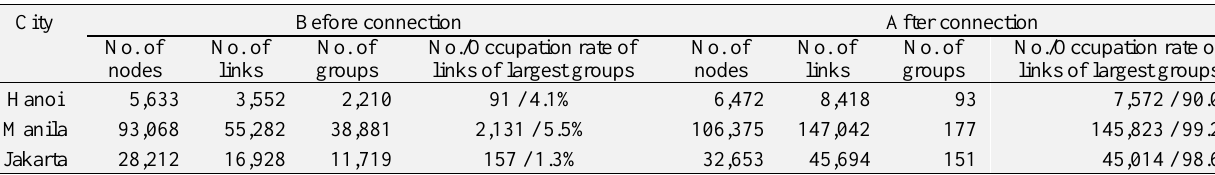
Table 1. Analysis of OSM in each city.